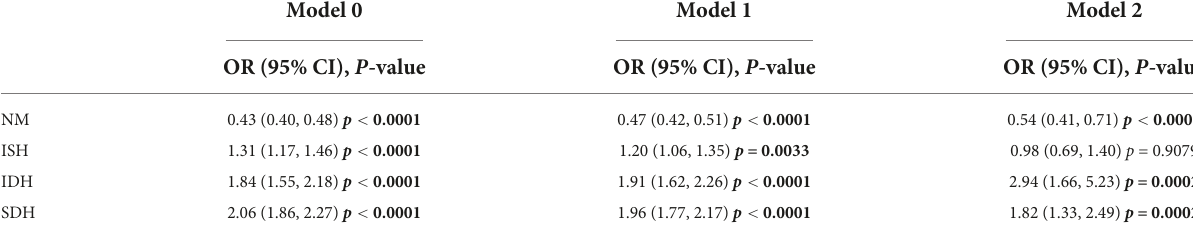
TABLE 3 Multivariate logistic regression analyses of the associations of increased TyG index and hypertension subtypes, Shandong, China (2007–2010). Model